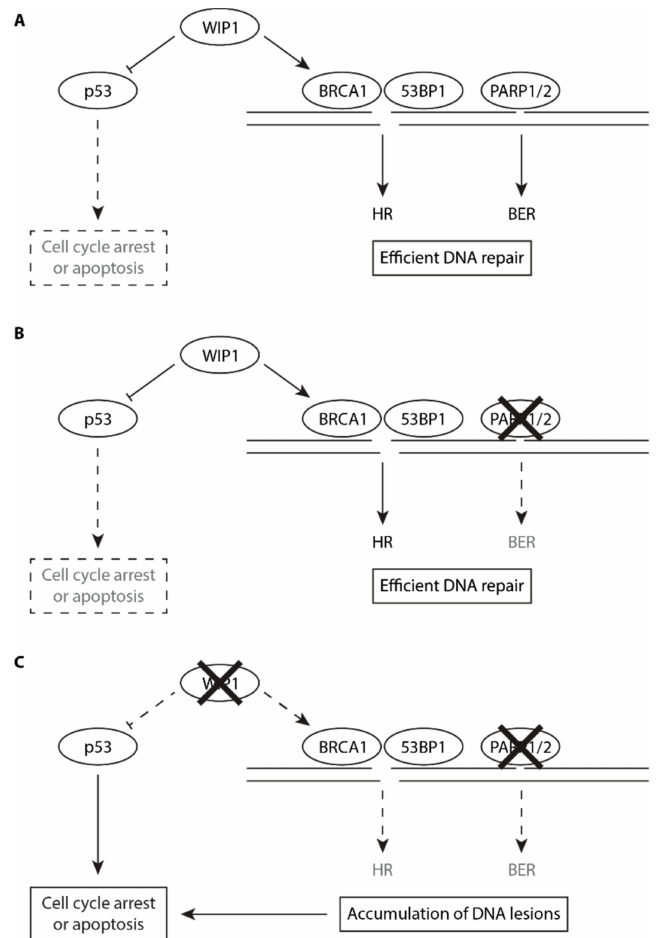
Figure 6. Putative model for the role of WIP1 in HR and in PARP inhibitor sensitivity. ( A ) Under normal conditions, endogenous DNA lesions are e ffi ciently repaired by HR and BER. WIP1 promotes e ffi ciency of HR and limits the extent of p53 pathway activation allowing cells to proliferate. ( B ) After inhibition of PARP1, BER pathway is impaired (dashed lines) but DNA lesions are e ffi ciently repaired by HR. ( C ) Combined inhibition of PARP1 and WIP1 impairs both BER and HR (dashed lines) and enhances p53 response leading to accumulation of DNA lesions in G2 cells. Increased DNA damage load triggers the DNA damage response and allows full activation of p53 pathway leading to cell